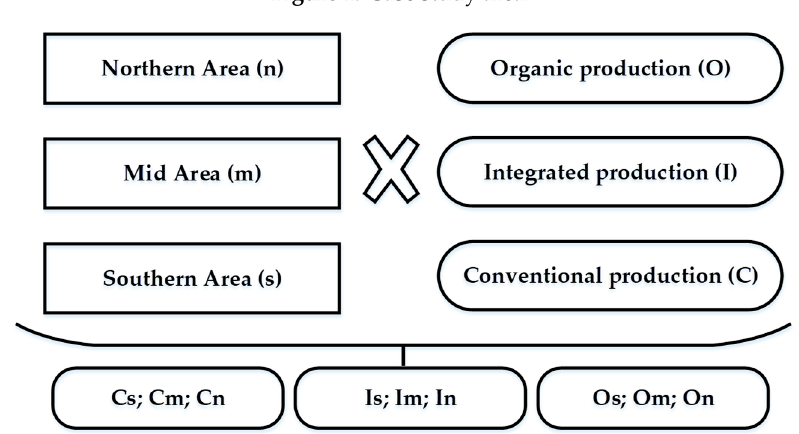
Figure 1. Case study area .